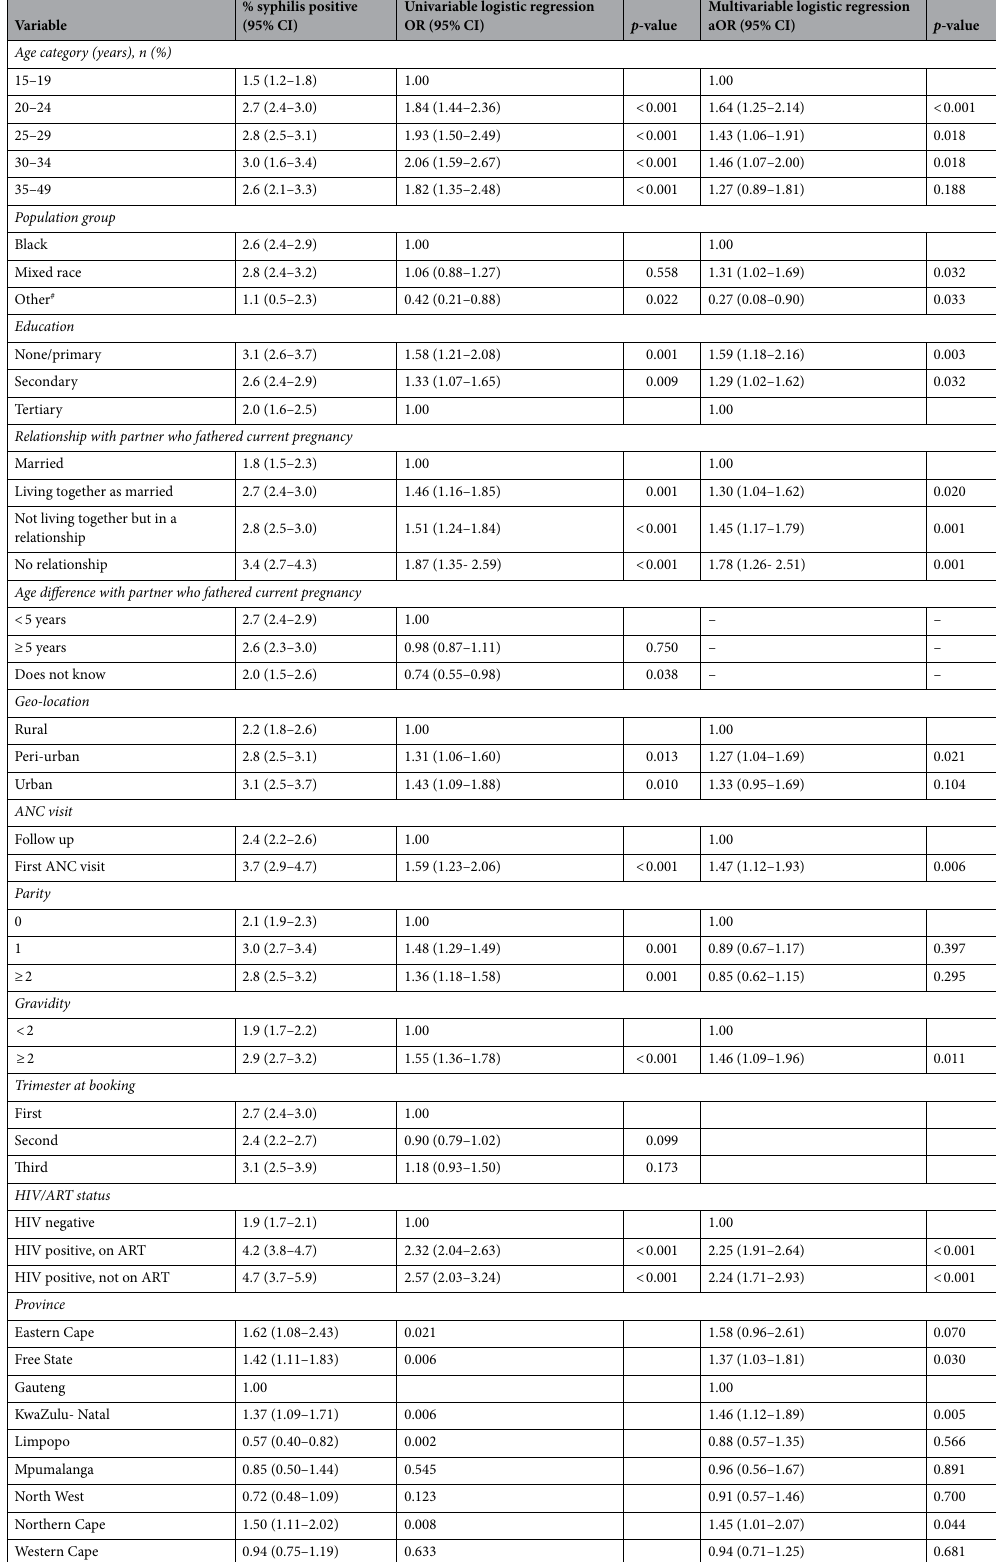
Table 2. Factors associated with being syphilis positive among pregnant women enrolled in the 2019 ANC survey and had documented syphilis screening results, South Africa, N = 24,064*. *This is 24 064/28 277 (85.1%) for whom syphilis results were available; # other race includes white, Asian and any other race individuals self-identified as; OR Odds ratio, aOR adjusted odds ratio, CI Confidence interval OR (95%